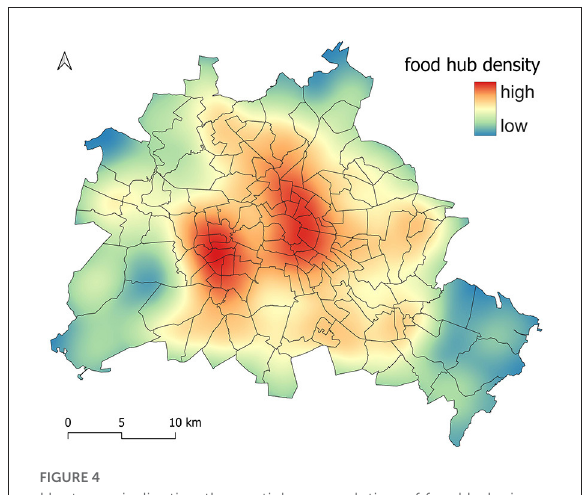
FIGURE4 Heat map indicating the spatial accumulation of food hubs in